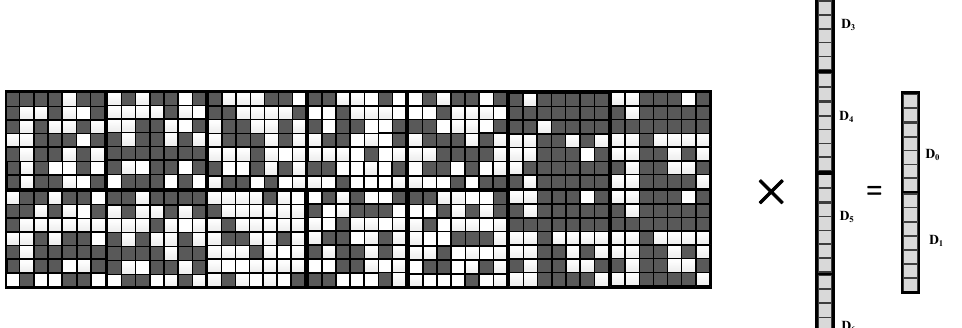
Figure 5. The non-aligned request.